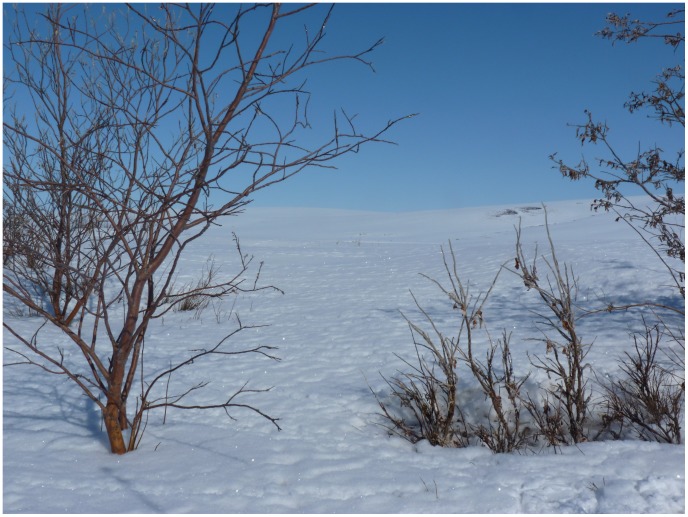
Un-broomed (left) and broomed (right) feltleaf willows (Salix alaxensis) in northern Alaska.Ptarmigan (Lagopus lagopus, L. muta) tracks are visible around the broomed willow.